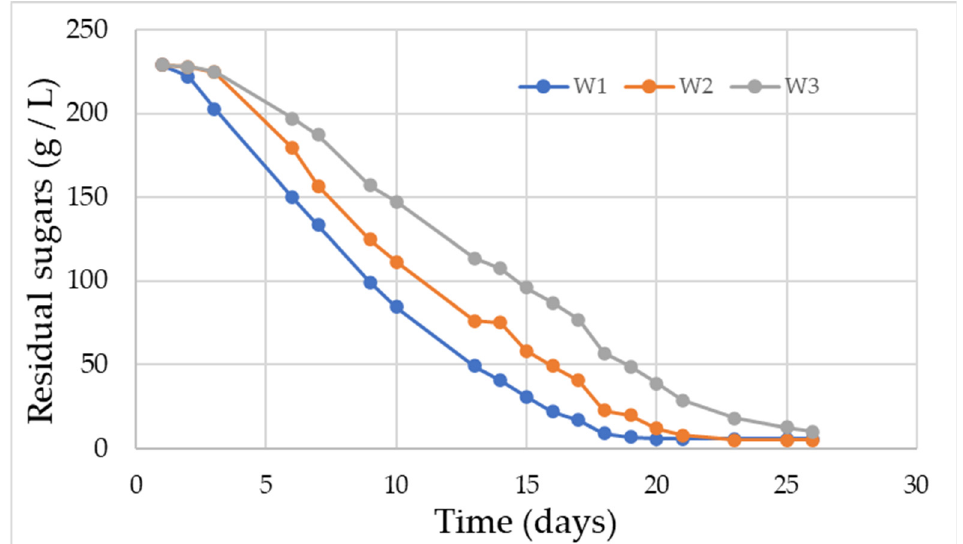
Figure 1. Sugar utilization profiles during fermentation. W1: single-culture fermentation with S. cerevisiae ; W2: single-culture fermentation with M. pulcherrima ; W3: sequential fermentations with M. pulcherrima and S. cerevisiae (the latter inoculated after 7 days). Fermentations inoculated with M. pulcherrima and M. pulcherrima / S. cerevisiae showed